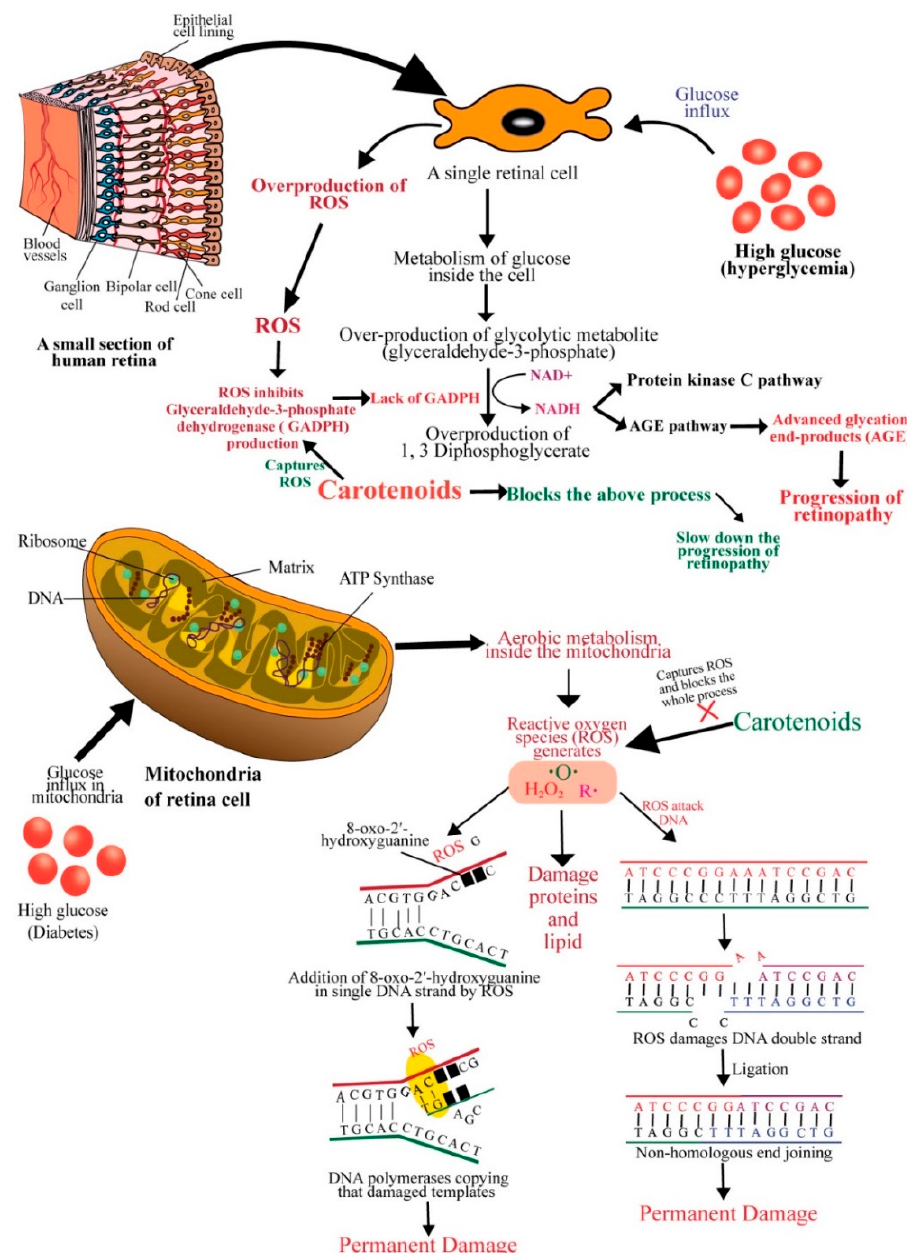
Figure 3. Schematic diagram showing the mechanisms of action of carotenoids to prevent diabetic retinopathy. ROS: reactive oxygen species; GADPH: glyceraldehyde-3-phosphate dehydrogenase; AGE: advanced glycation end-product; DNA: deoxyribonucleic acid; ATP: adenosine triphosphate.